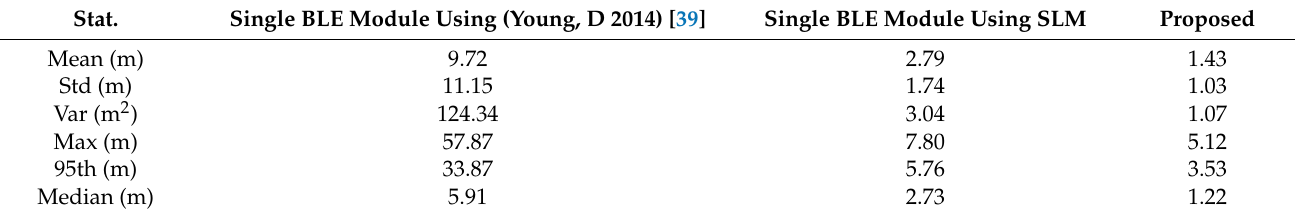
Figure 6. Comparison of ranging error versus time epoch between BLE unit-based and MMBB-based methods [39]. Table 2. The comparison of dynamic ranging errors.